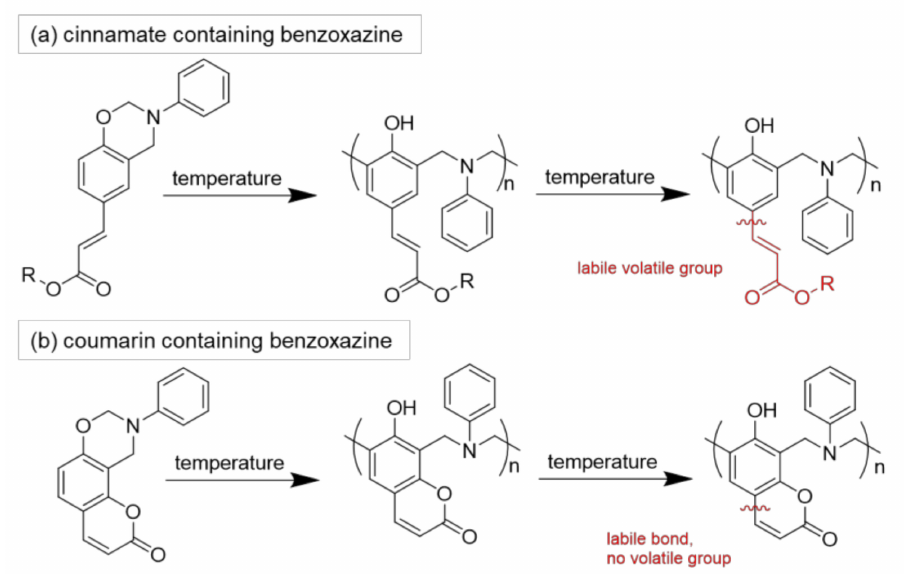
Figure 18. Possible degradation mechanism in ( a ) cinnamate and ( b ) coumarin containing benzox- azines during polymerization at elevated temperatures [138].